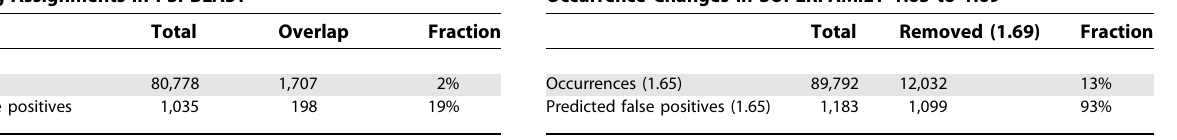
Table 3. Overlapping Regions in